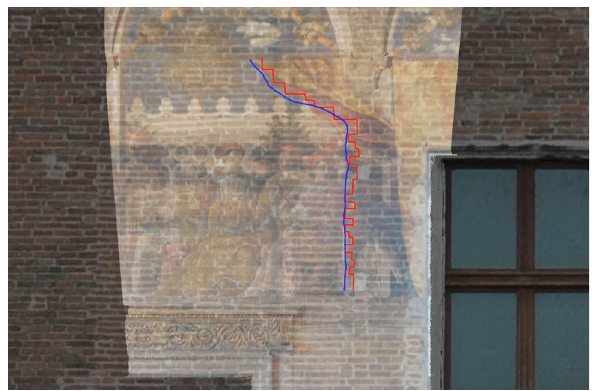
Figure 15. Overlapped